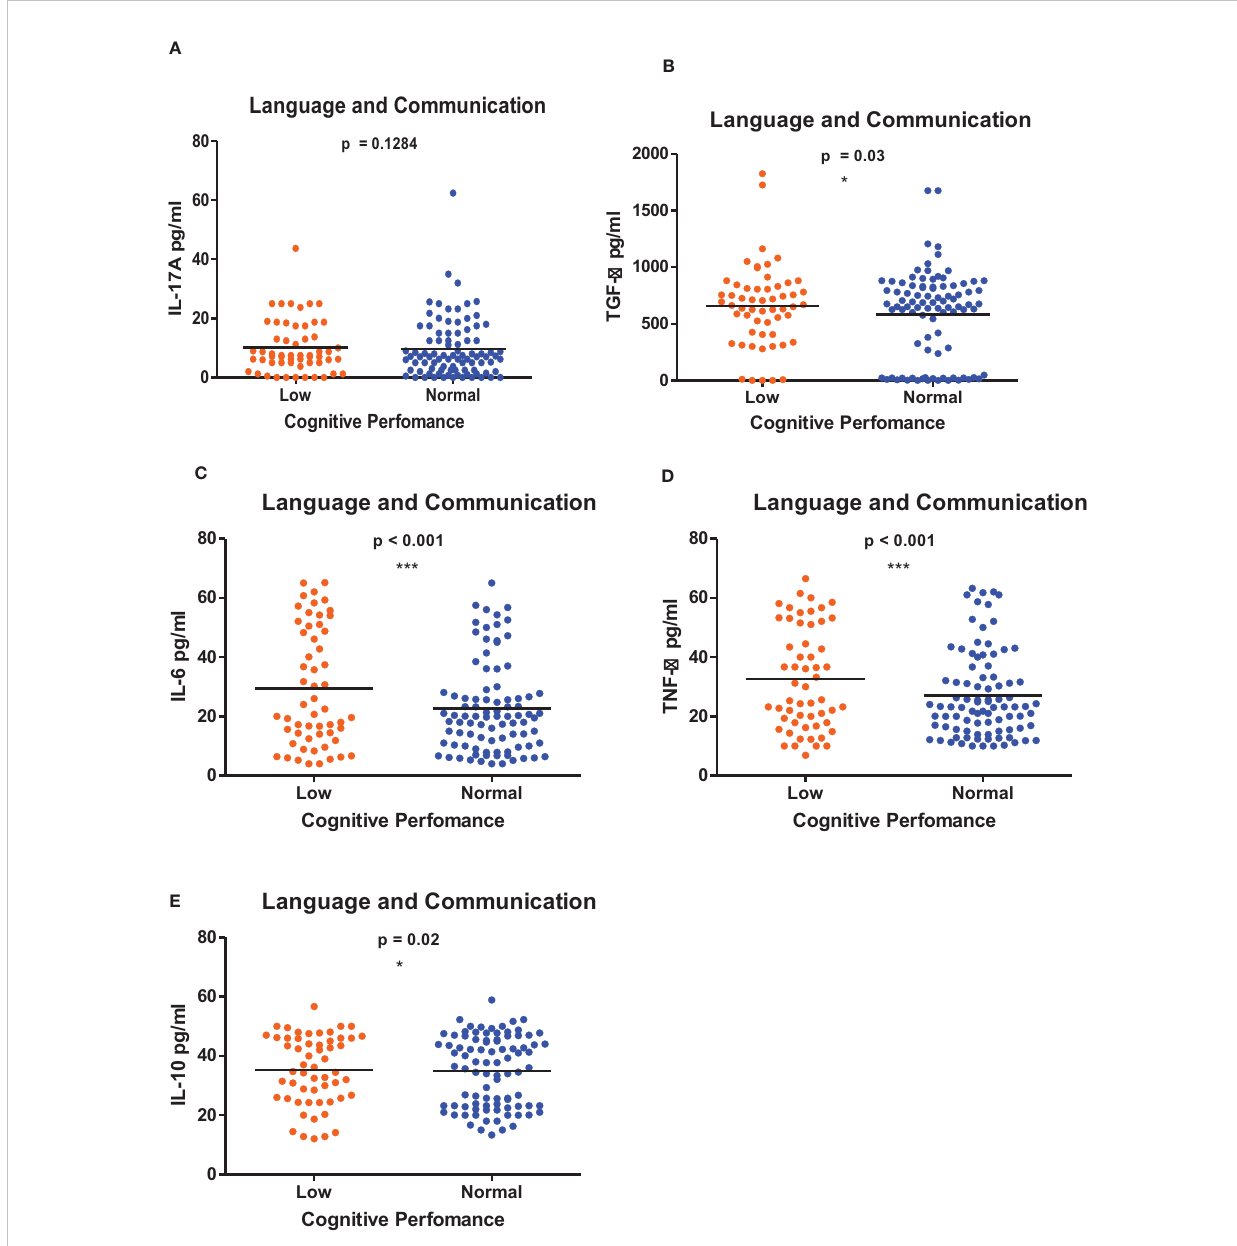
FIGURE 2 (A-E) Cytokine concentration level comparisons between low and normal PSAC performers in the Language and Communication Domain using the Wilcoxon matched-pairs signed rank test. * = p ≤ 0.05, *** = p ≤